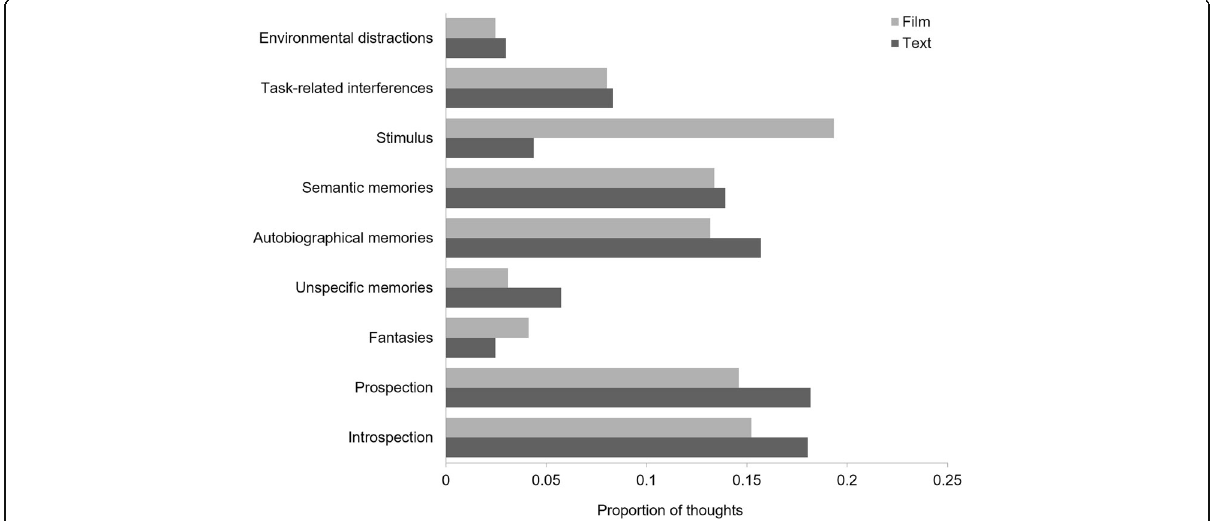
Fig. 1 Proportions of thoughts per category per task pooled across thoughts ( light gray : film comprehension, dark gray : text